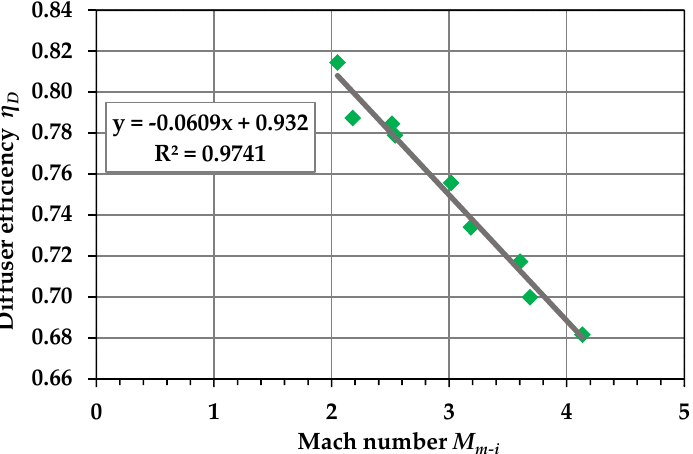
Figure 8. Experimental relationship between the diffuser efficiency η D and the Mach number M m − i of the motive gas at the final pressure p i .